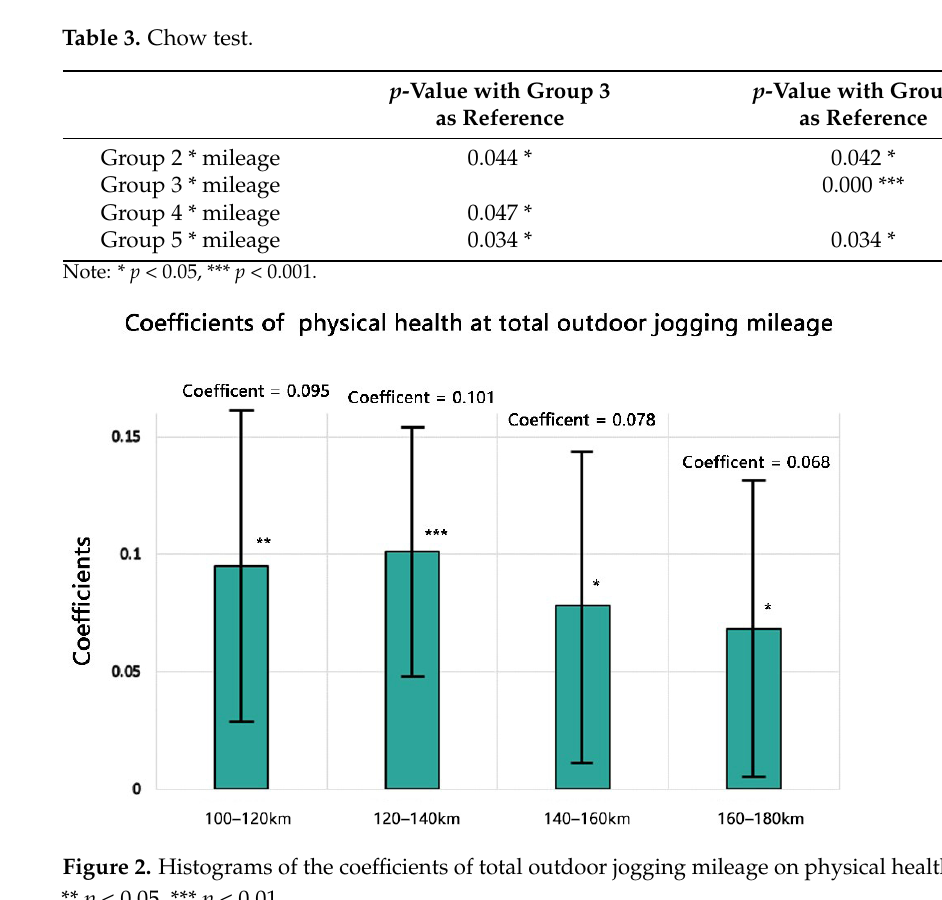
Figure 2. Histograms of the coefficients of total outdoor jogging mileage on physical health. * p < 0.1, ** p < 0.05, *** p < 0.01.